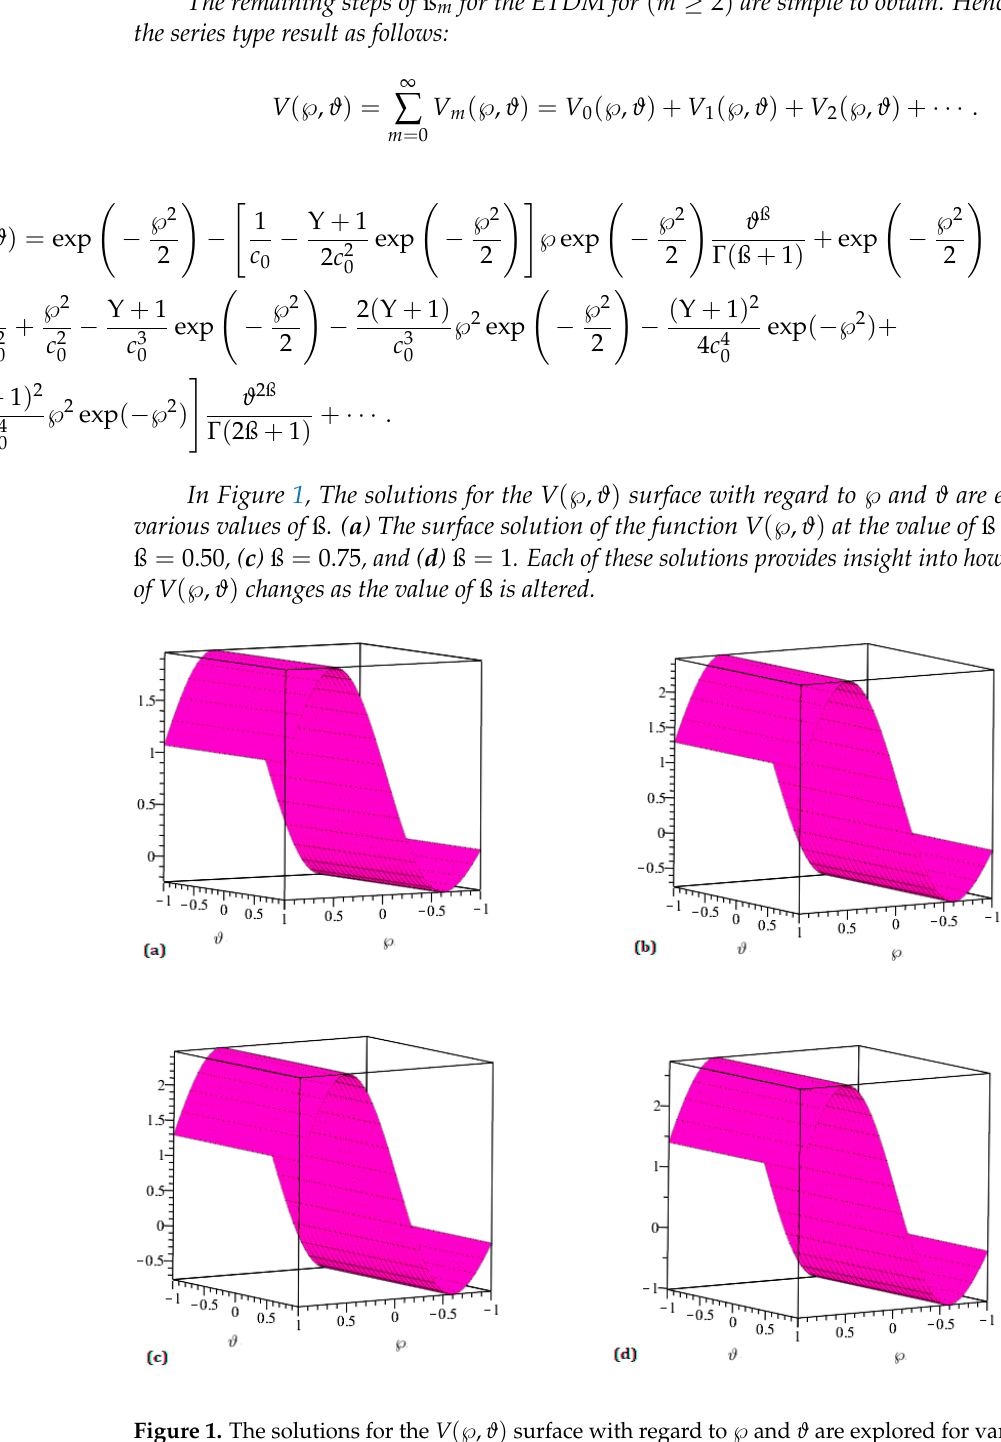
Figure 1. The solutions for the V ( ℘ , ϑ ) surface with regard to ℘ and ϑ are explored for various values of ß. ( a ) The surface solution of the function V ( ℘ , ϑ ) at the value of ß = 0.25, ( b ) ß = 0.50, ( c ) ß = 0.75, and ( d ) ß = 1. Each of these solutions provides insight into how the surface of V ( ℘ , ϑ ) changes as the value of ß is